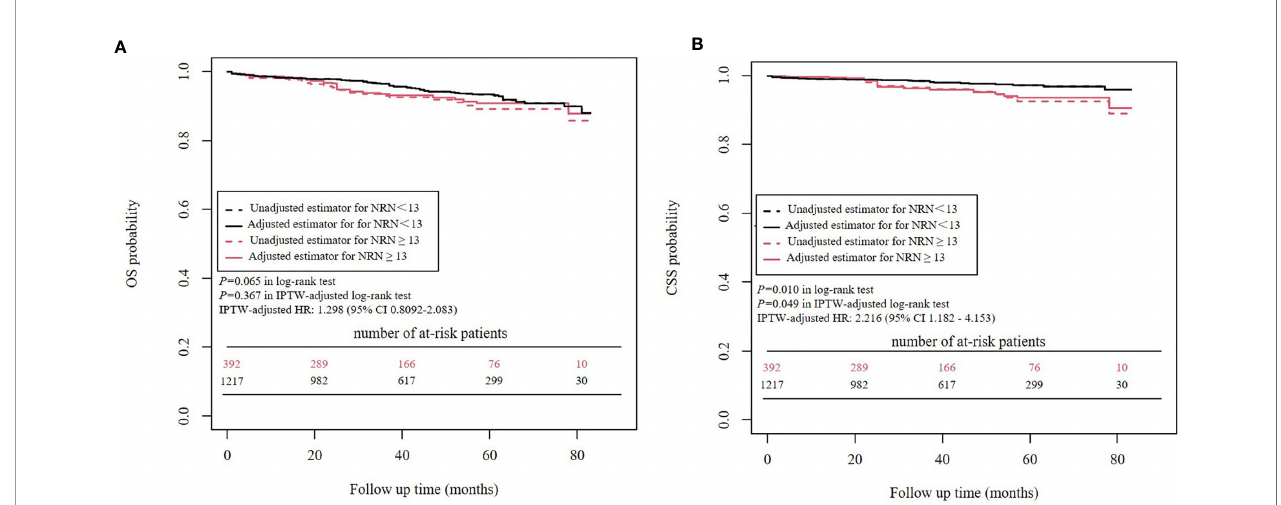
FIGURE 5 | Survival analysis of NRN before and after IPTW. (A) OS analysis (B) CSS